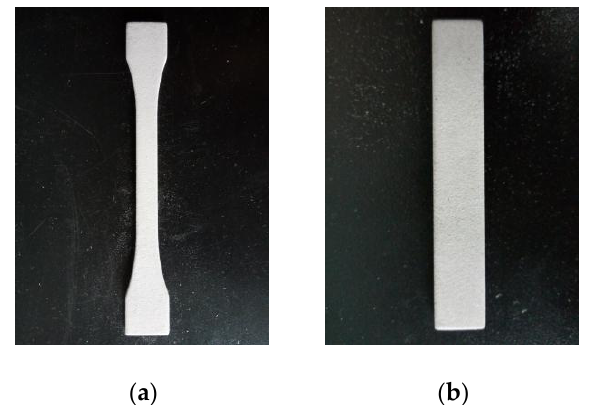
Figure 3. A photograph of the completed CNT/WPCs tensile test specimen ( a ) and the flexural test specimen by SLS ( b